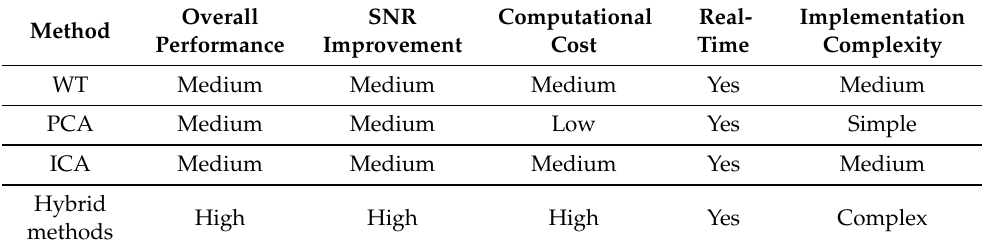
Table 2. Summary of the EP signal processing methods.